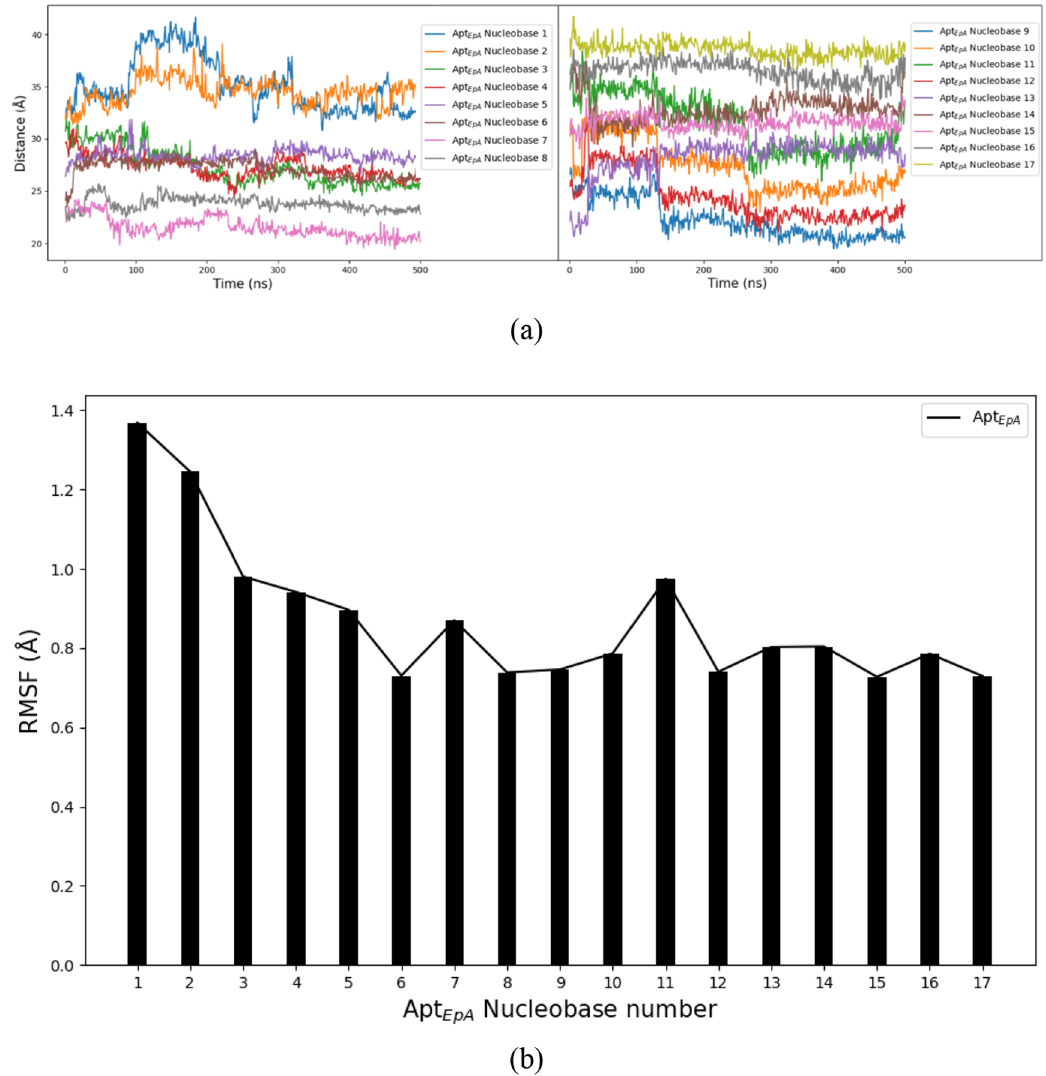
Figure 10. ( a ) Variations of distances between Apt EpA nucleobases and EpCAM mass centre during the CGMD simulation for 500 ns. ( b ) RMSF analysis results for Apt EpA